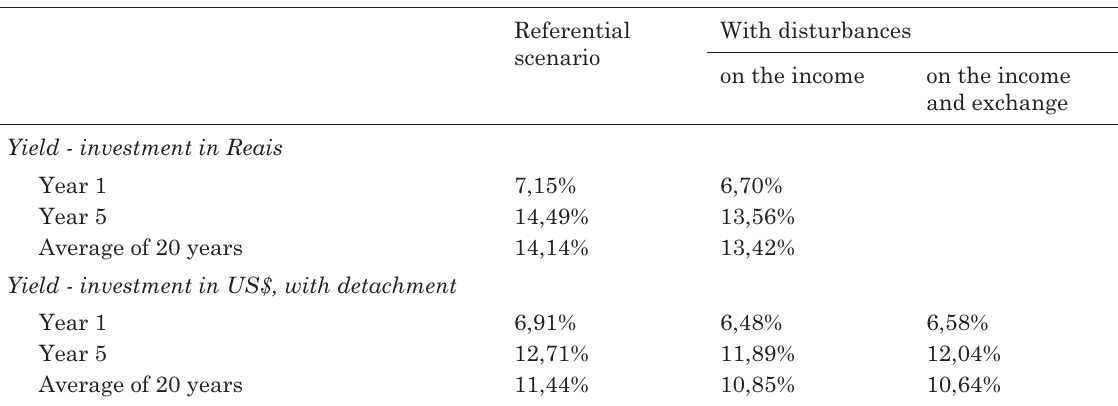
Table 7. Investment quality indicators – annual yield according to strategy II Performance according to the referential scenario, with and without disturbances